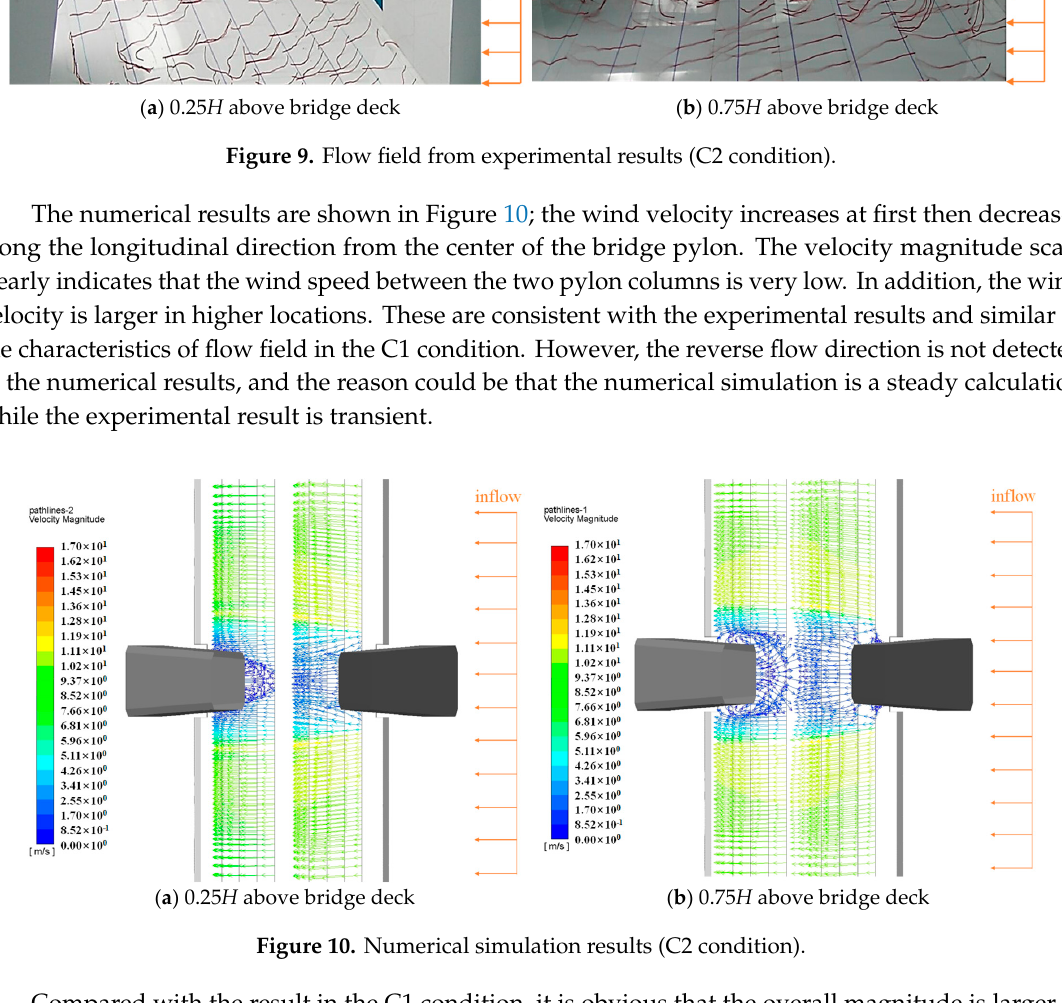
Figure 10. Numerical simulation results (C2 condition).